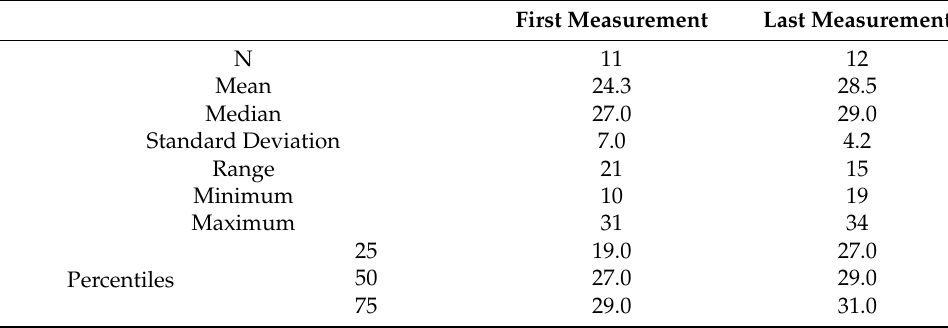
Table 3. SWEMWBS scores—descriptive